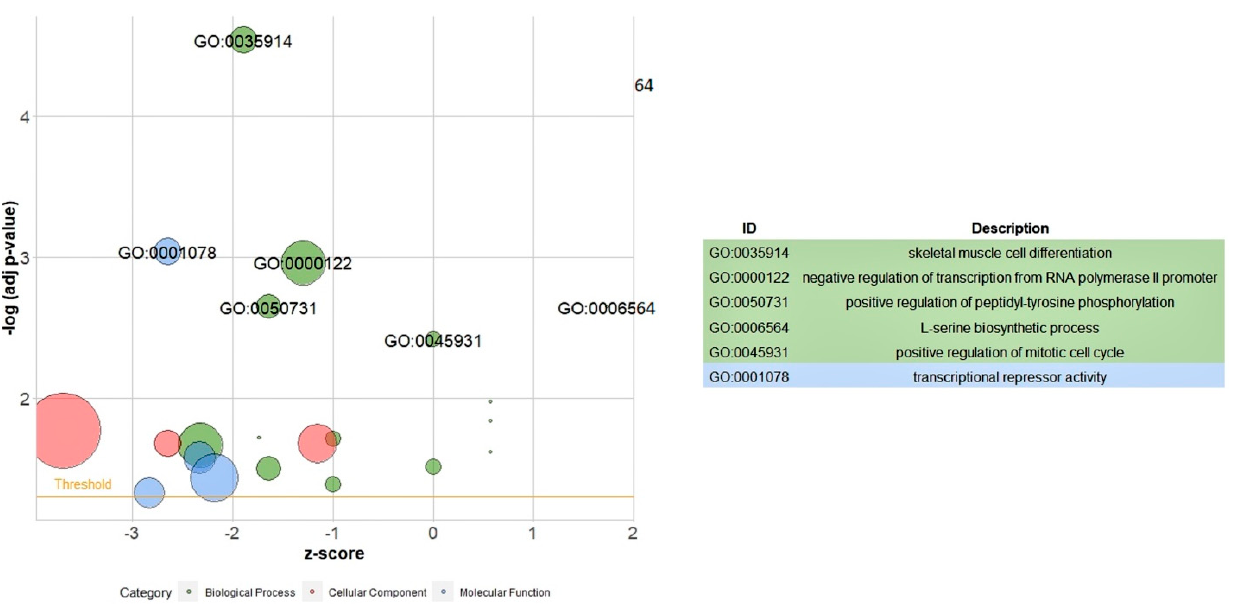
Figure 3. Gene ontology analysis of all DEGs. The bubble plot shows the GO enrichment of dif- ferentially expressed genes in five biological process terms and one molecular function.